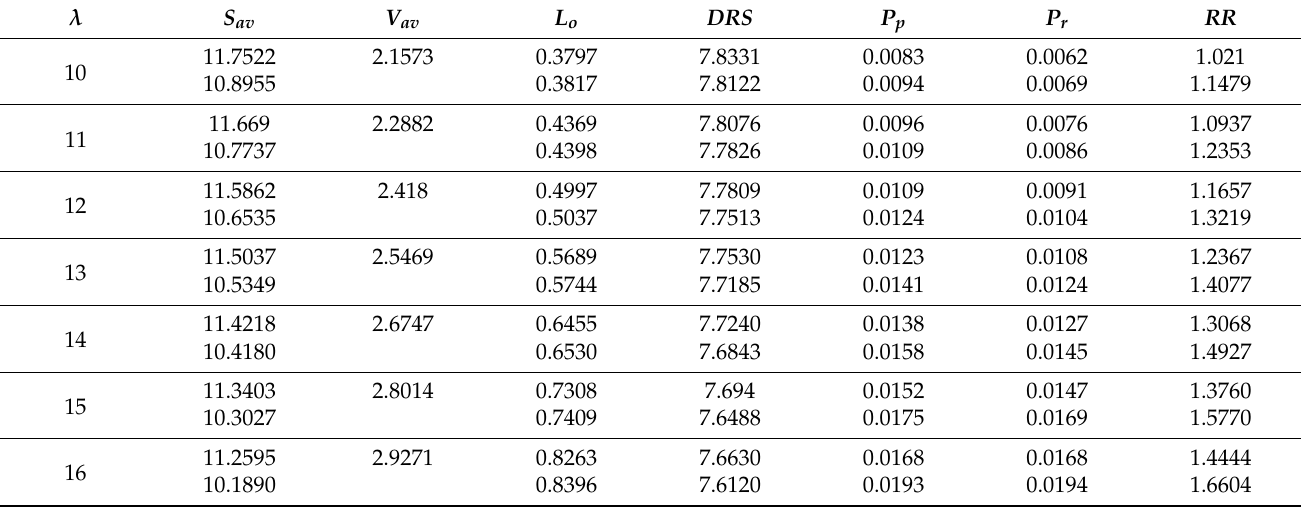
Table 1. Dependence of the performance measures on parameter λ ; η = 15, κ = 8, ν = 10, α = 0.4, and β = γ =